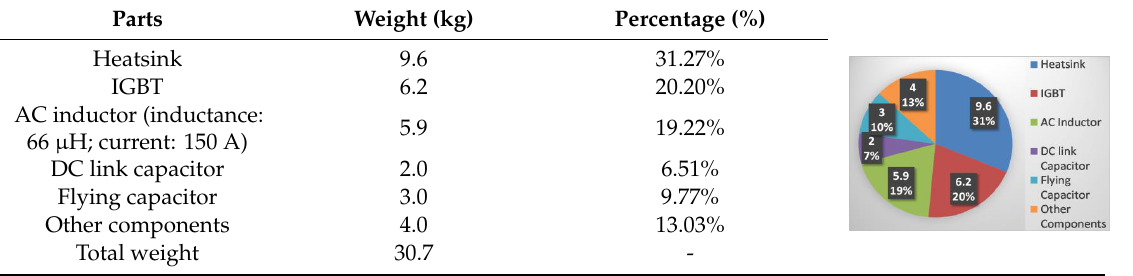
Table 6. Weight distribution analysis for the converter prototype.